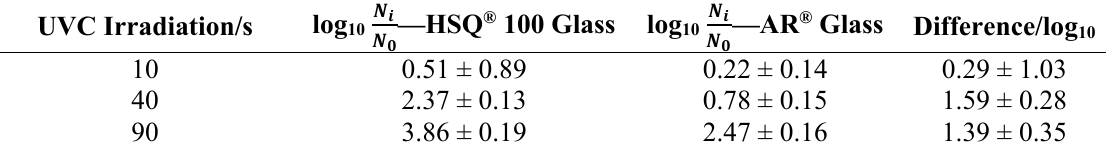
Figure 13. Disinfection results expressed in log 10 levels for B. subtilis (1–3 × 10 6 CFU/mL) with additional mixing during UVC irradiation. Table 4. Inactivation results for HSQ ® 100 and AR ® glass types for B. subtilis DSM 402 after different UVC irradiation periods and the corresponding differences of microbial inactivation in log 10 in mixed